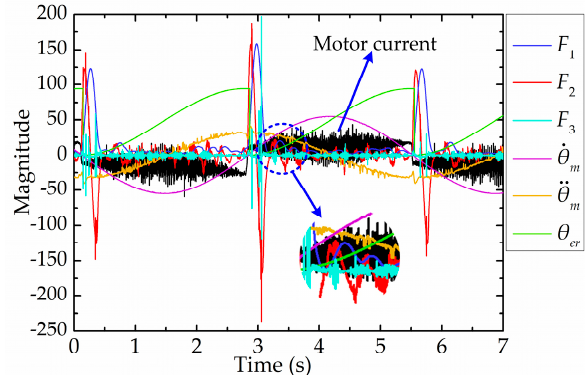
Figure 11. Initial selected features for SVM.